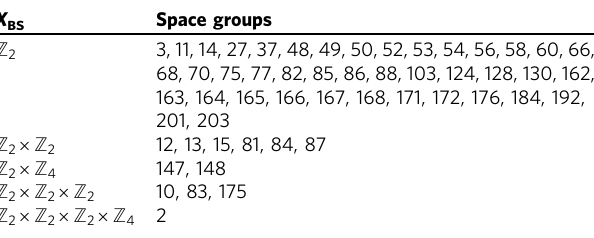
Table 4 Symmetry-based indicators of band topology for systems with time-reversal symmetry and negligible spin – orbit coupling X